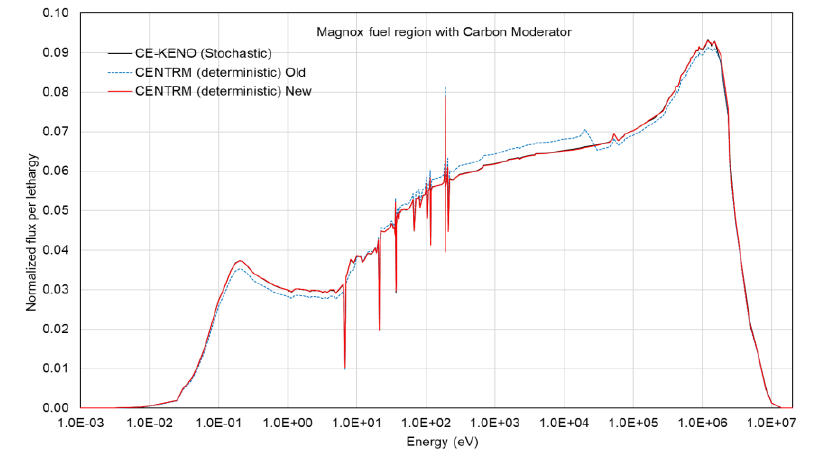
Figure 2. Neutron flux normalization in CENTRM.